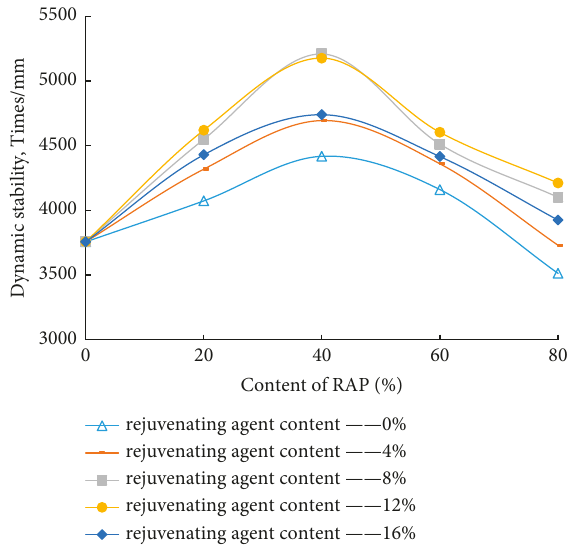
Figure 7: MS test results with different content of RAP. ′